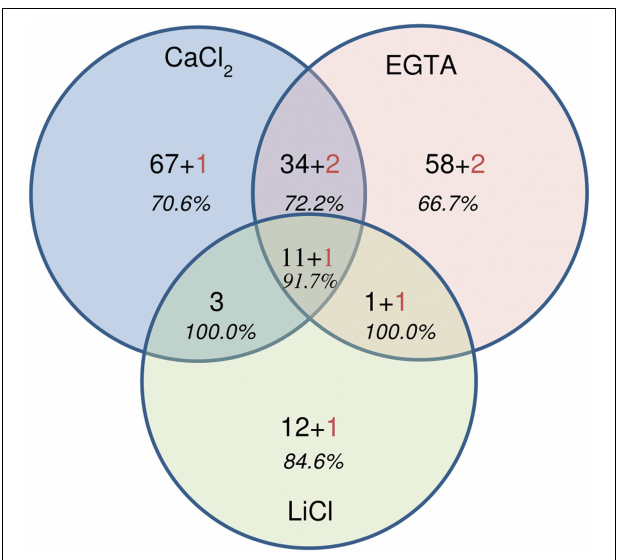
FIGURE 6 | Venn diagram showing the repartition of the 194 proteins identified by MALDI-TOF-TOF. Numbers in black correspond to the number of plant proteins, numbers in red indicate the number of fungal proteins. In italics, the percentage of cell wall proteins (CWPs) is indicated.